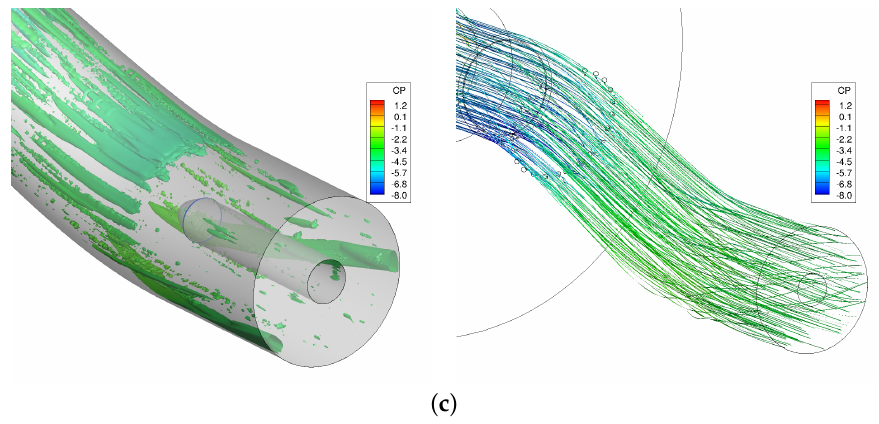
Figure 16. Isosurfaces of scale Q-criterion (iso value of 0.25) and streamlines colored by pressure coefficient. USAFA grids and SARC-DDES turbulence models were used. CFD data are time-averaged from 2 to 2.5 s of simulation time. ( a ) Baseline; ( b ) Baseline + VG; ( c ) Baseline + Jets.